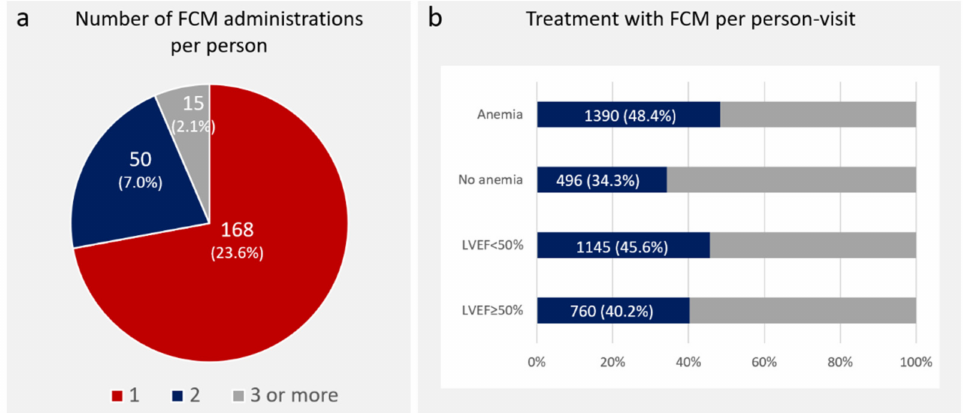
Figure 2. Treatment with FCM. ( a ) Number of FCM administrations of iron per person during the follow-up period; ( b ) rates of FCM administration per person visits, depending on the pres- ence of anemia and among LVEF subgroups. FCM: ferric carboxymaltose; LVEF: left ventricle ejection